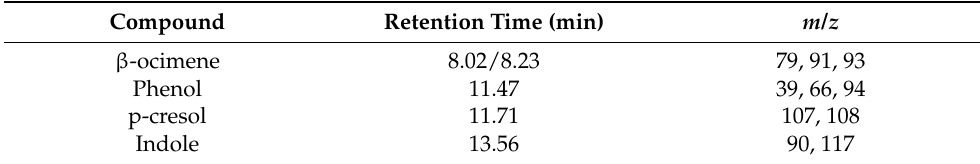
Table 2. Experiment matrix for